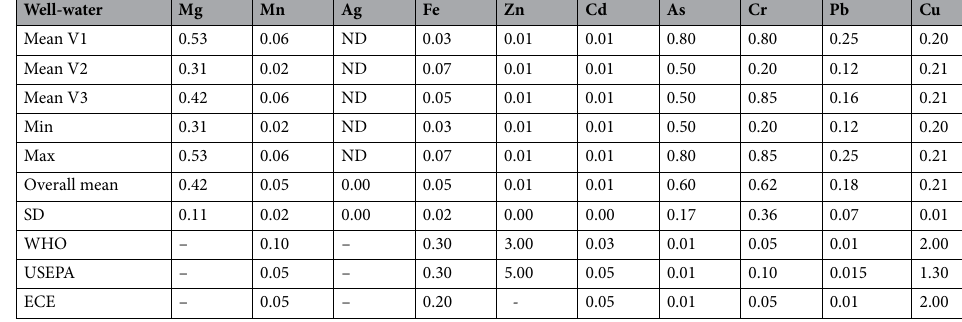
Table 7. Mean concentration of HMs in well-water samples collected from the control site in ppm. Detection Limit for Ag = 0.050 ppm. ND/NA not detectable/available, WHO World Health Organization 46 , USEPA United Stated Environmental Protection Agency 47 , ECE European Commission Environment 48 .